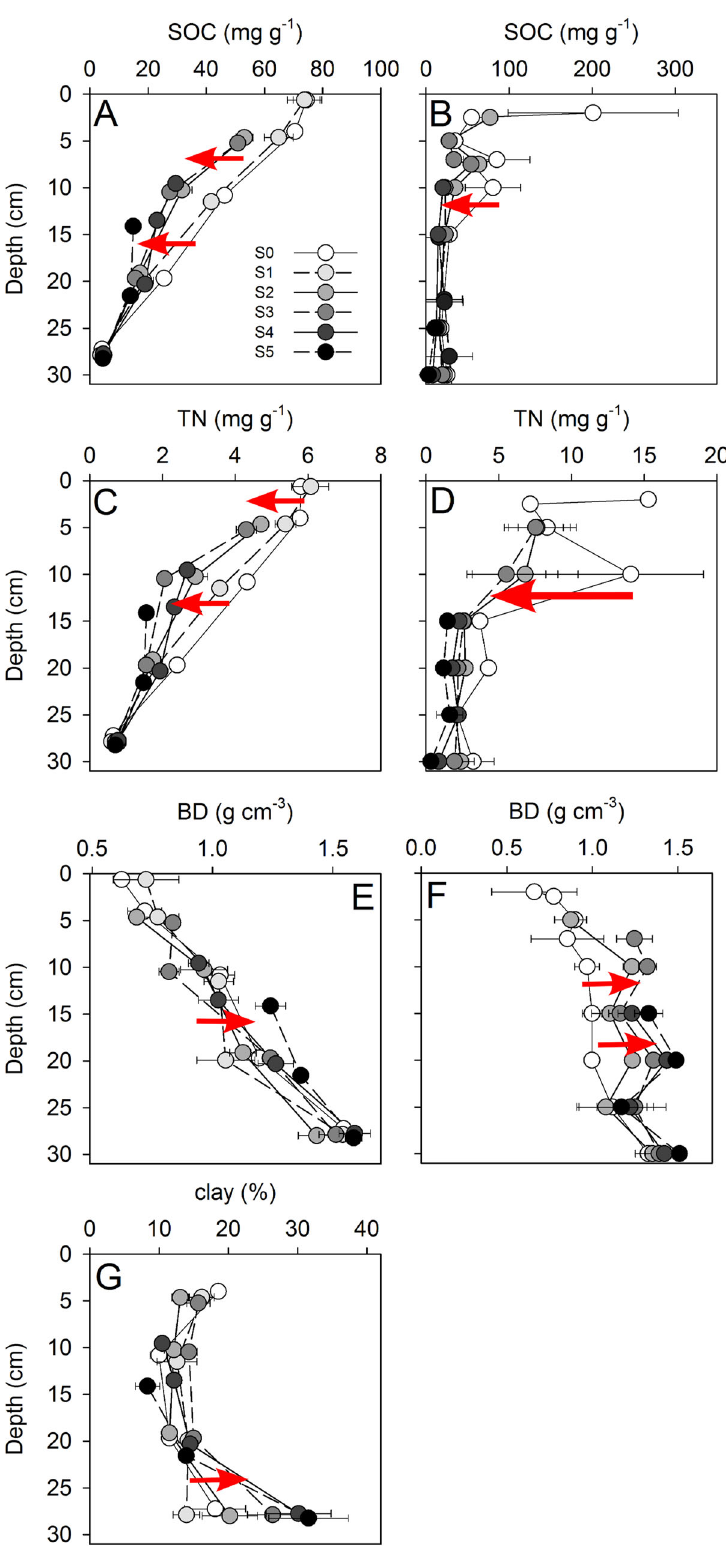
Fig. 1 Changes in soil characteristics with depth according to degradation stage. A soil organic carbon (SOC) core study site, B SOC literature study, C total nitrogen (N) core study site, D total N literature study, E bulk density (BD) core study site, F BD literature study, G clay content core study site. All parameters are presented for each soil horizon at the midpoint of the depth increment. Error bars display standard error. Exact data are provided in Supplementary Table